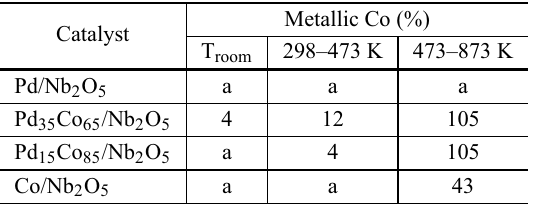
Magnetic measurements of reduced bimetallic catalysts (Noronha et al. 2000b).